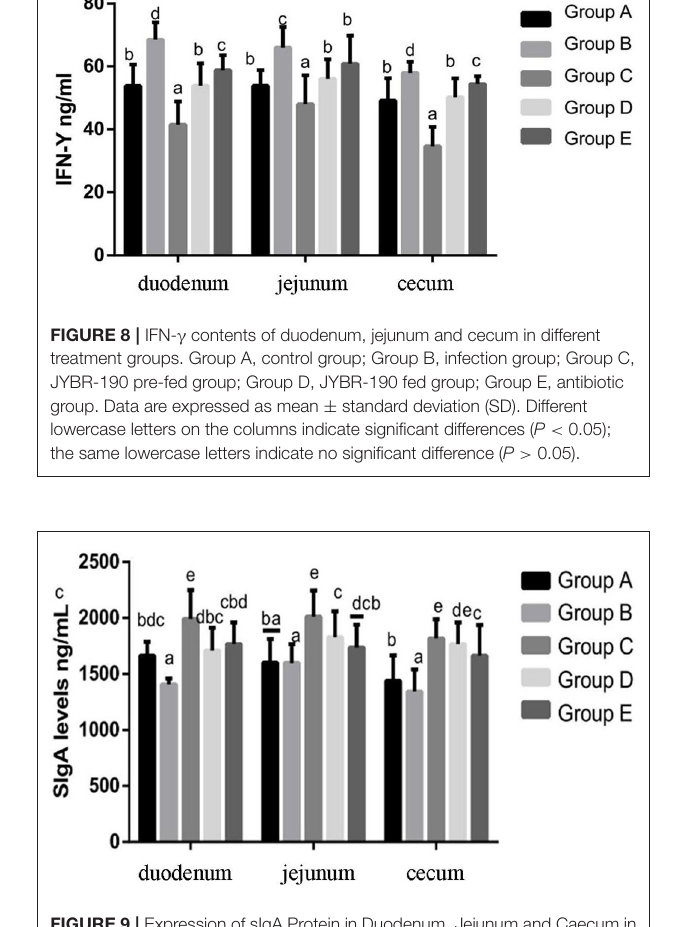
and absorption capacity. Samanya et al. found that Bacillus subtilis can increase the height of ileal villi in adult males and improve feed conversion efficiency (18). In this